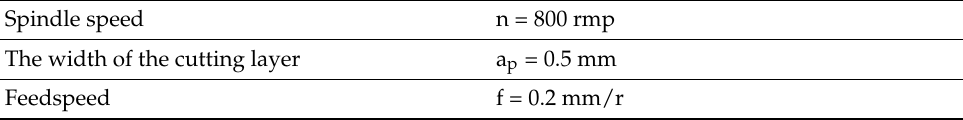
Table 3. Technological parameters of the cutting process during finishing machining. Spindle